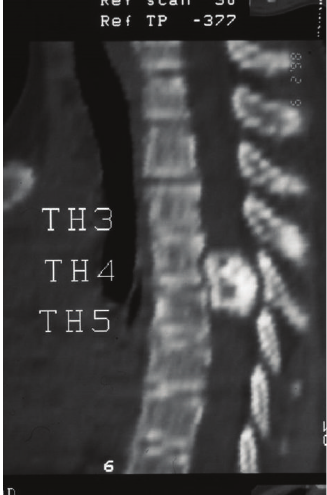
Figure 2: Reformatted sagittal CT scan showed a lesion arising from the T3–5 lamina and indenting the spinal cord (obliteration and stenosis of the spinal canal at the level of T3).